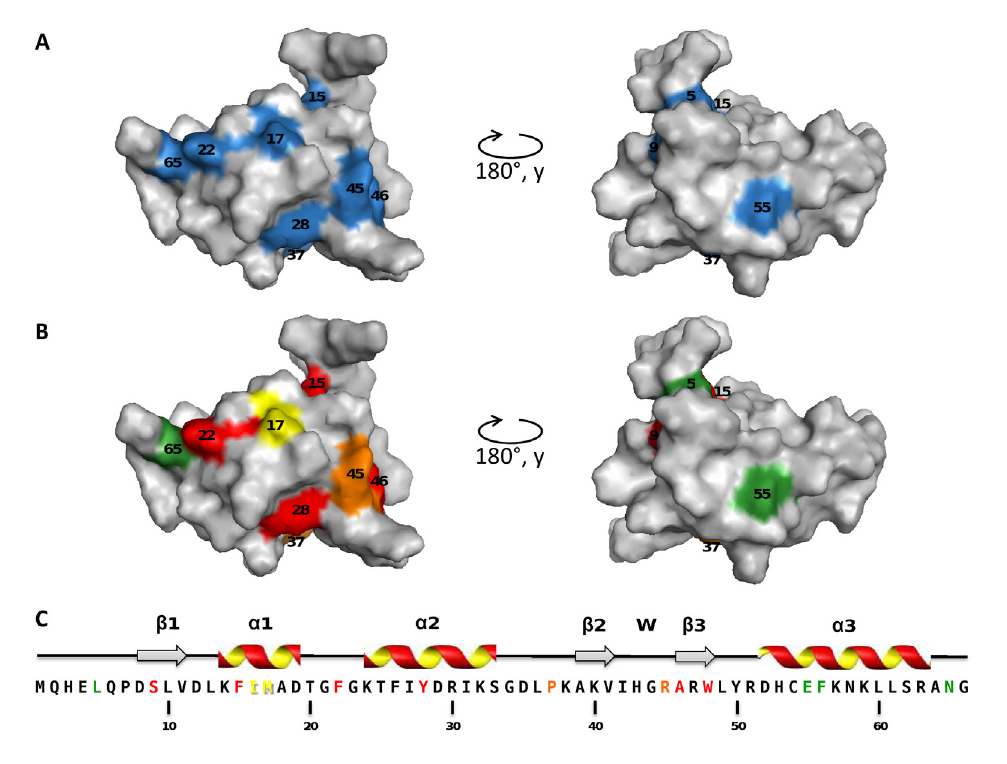
Figure 2. Mapping of the mutations that affect the anti-RR function ( A ) or the recombination directionality factors (RDF) activity ( B ) of TorI; Secondary structures of the TorI protein ( C ). Color code is as follows: blue , no anti-RR activity; green , 80 to 100% of the WT activity; yellow , 1 to 10%, orange , 0.1 to 1%, and red , no RDF